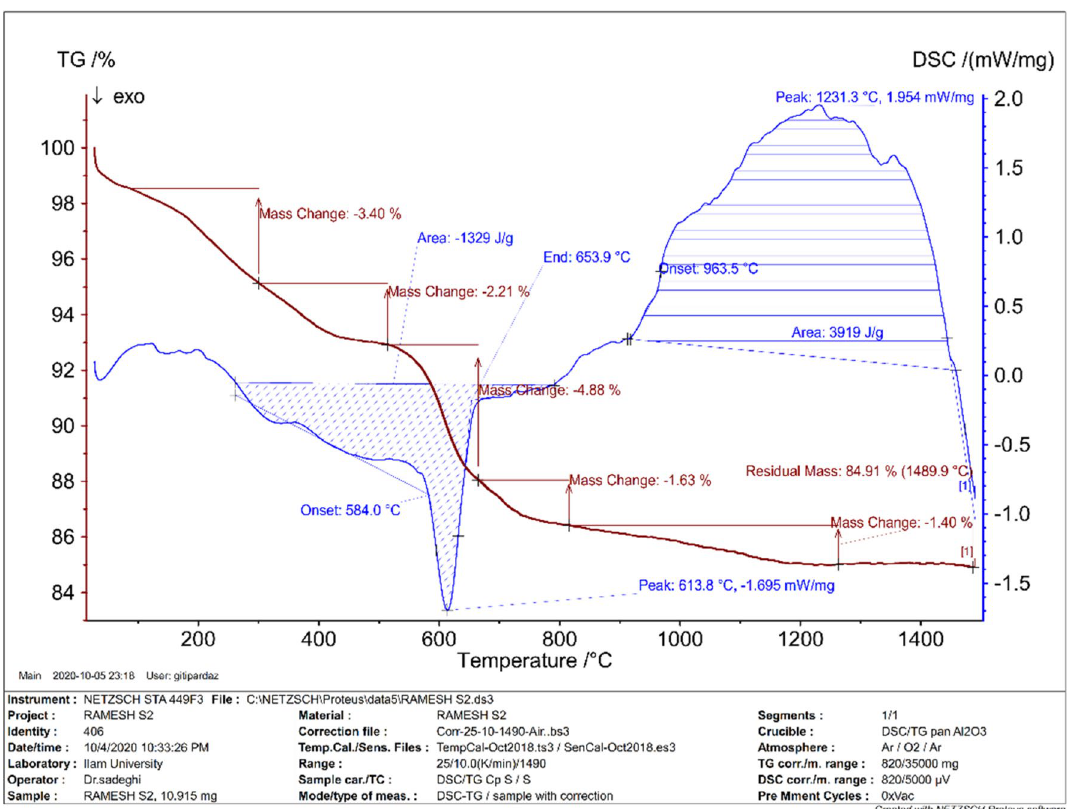
Figure 3. TGA (Maroon line) and DSC (Blue line) curves of nanoporous Zn-MOF